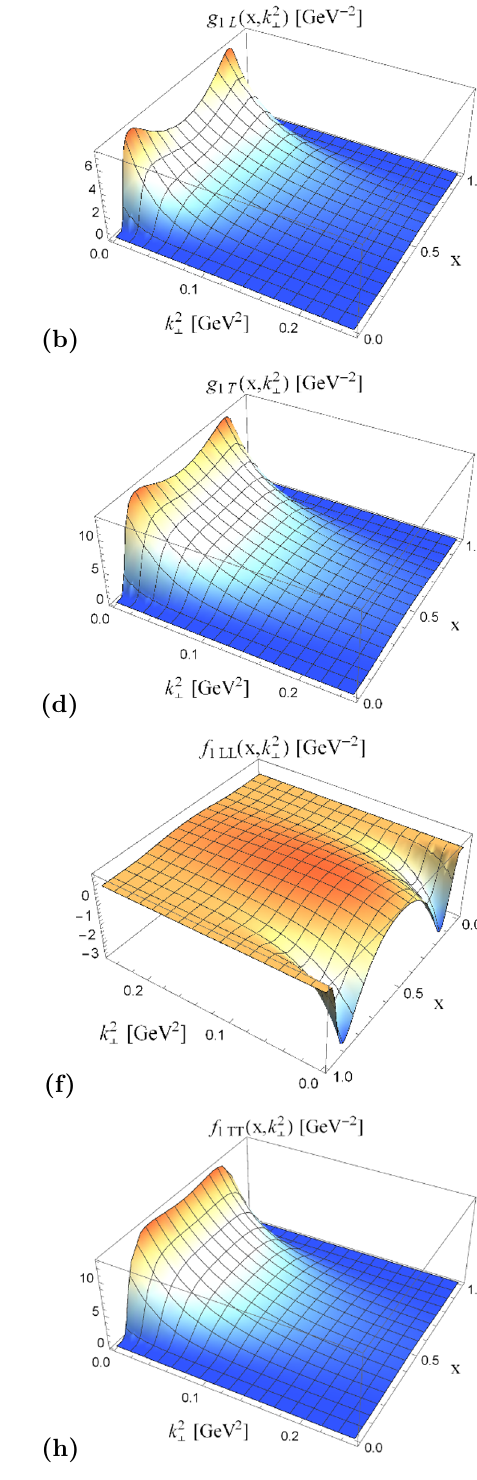
Figure 4 . (Color online) Light-front holographic TMDs of the ρ -meson as a function of x and k 2 at the model scale µ 2 = 0 . 20 GeV 2 LFH